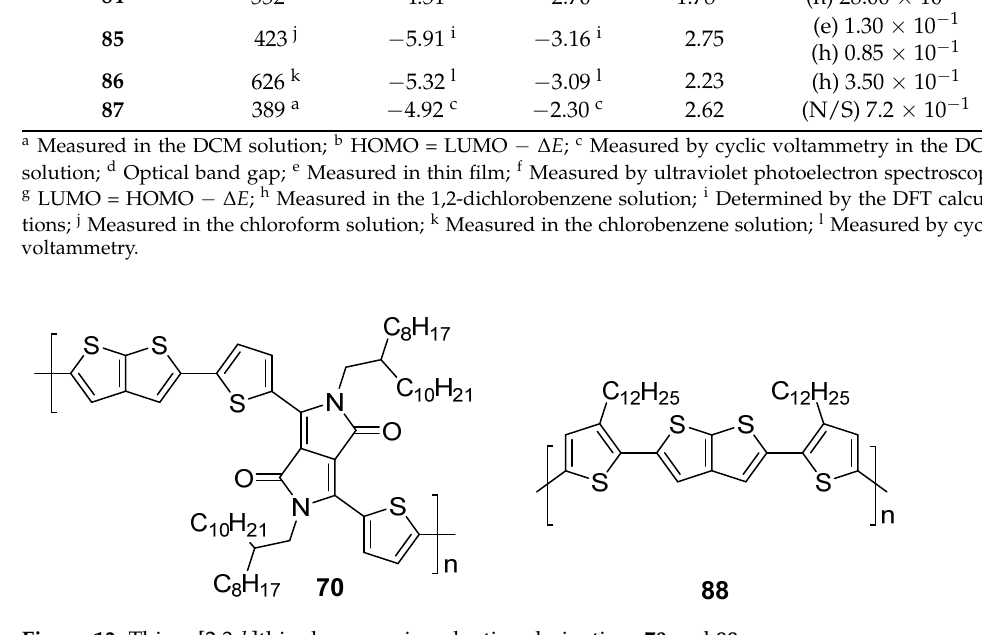
Figure 12. Thieno[3,2- b ]thiophene-derived semiconductors 82 – 87 .